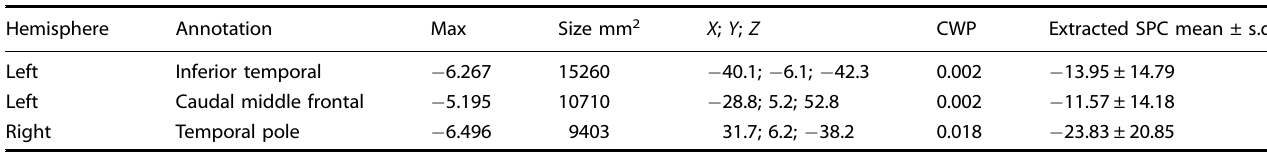
CWP Cluster-wise P value; Max maximum − log10 P value of the cluster. Size: cluster surface area in mm 2 ; SPC symmetrized percentage change; extracted from the annotated region. X ; Y ; Z : Talairach coordinates of the